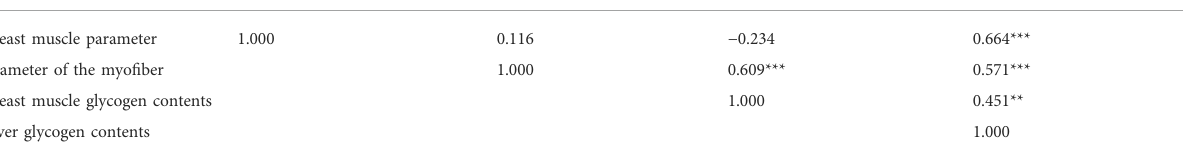
TABLE5Partialcorrelationsamongbodyweight,smallintestine,andbreastmuscleparameters,liverandbreastmusclecontents,andbreastmuscle- related gene expression. Variable